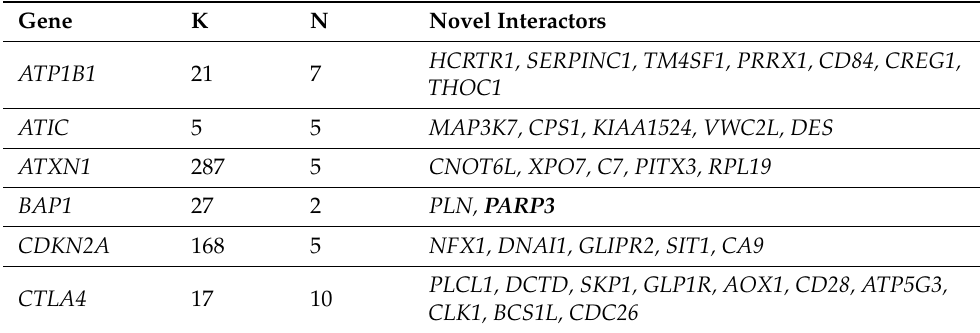
Table 1. Novel Interactors of each of the malignant pleural mesothelioma (MPM) Genes: Number of known (K) and computationally predicted novel (N) protein-protein interactions (PPIs) and lists the novel interactors. Bold genes in the 4th column are Novel Interactors that were experimentally validated in the current